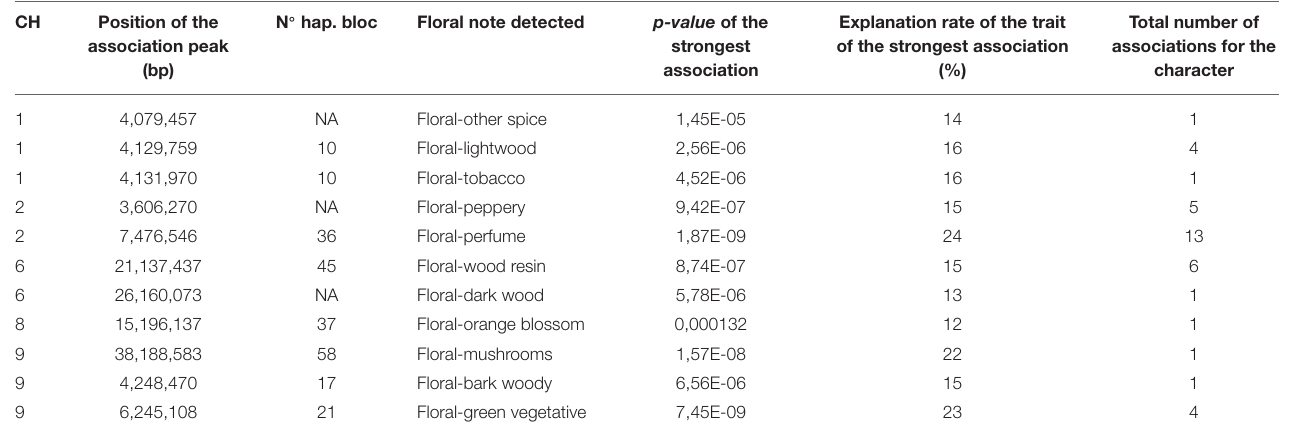
TABLE 2 | Most significant association detected for each of the sensory floral